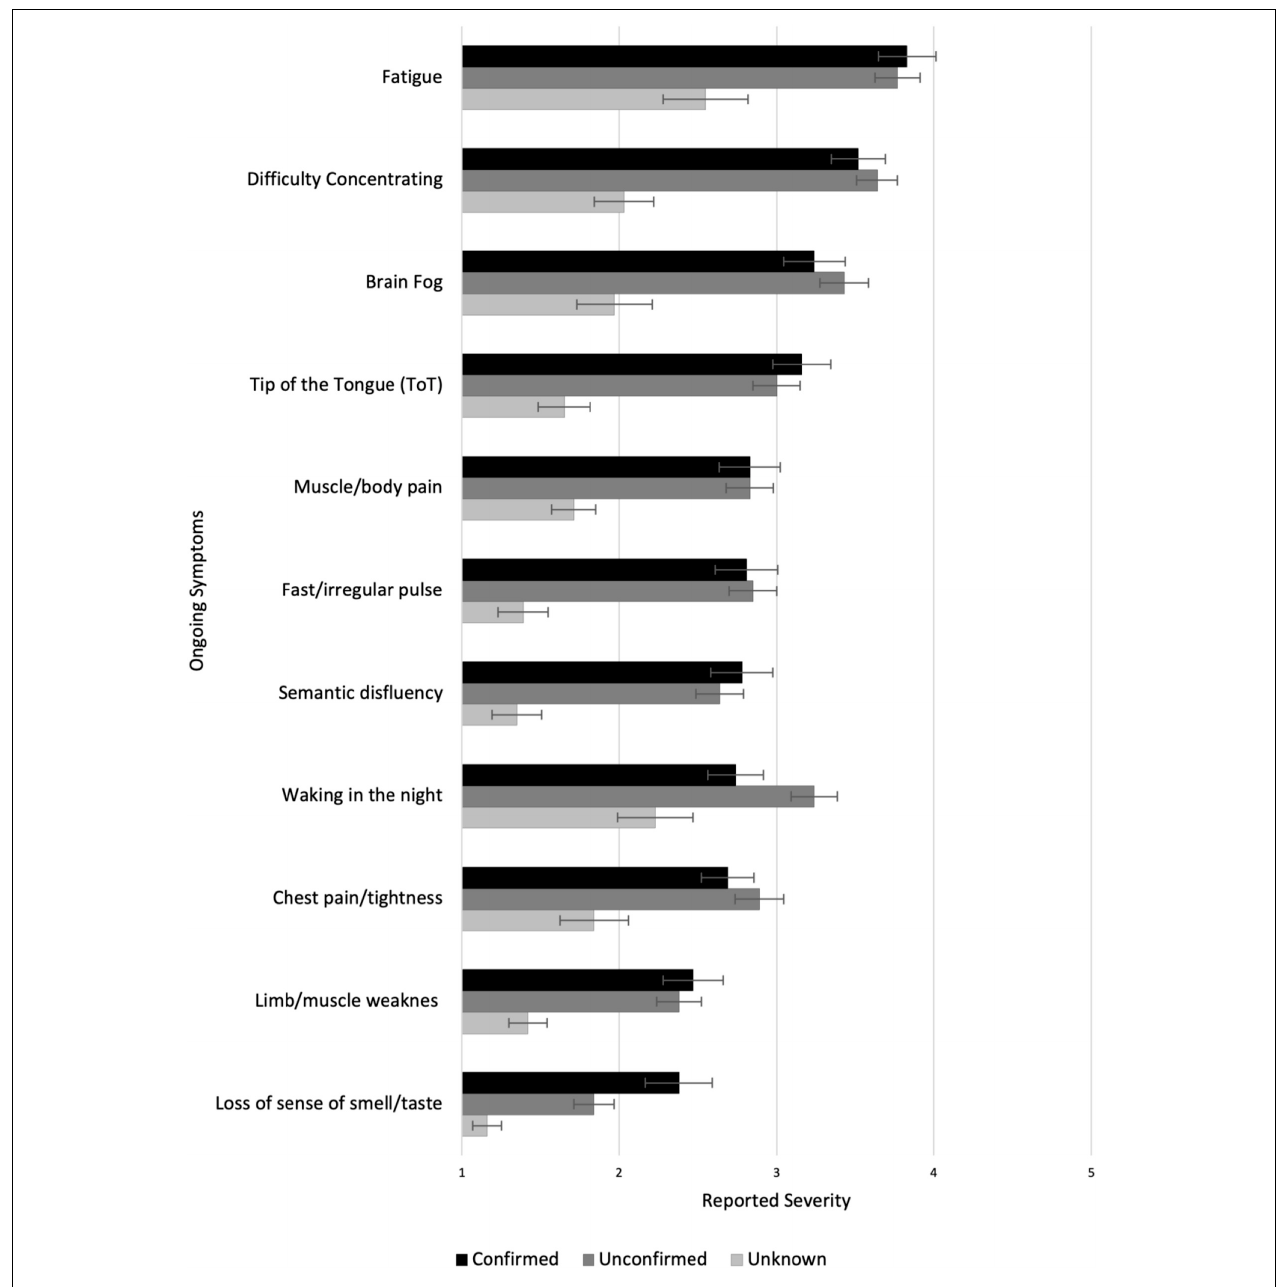
FIGURE 5 | Experience of ongoing symptoms in Unknown, Unconfirmed COVID, and Confirmed COVID